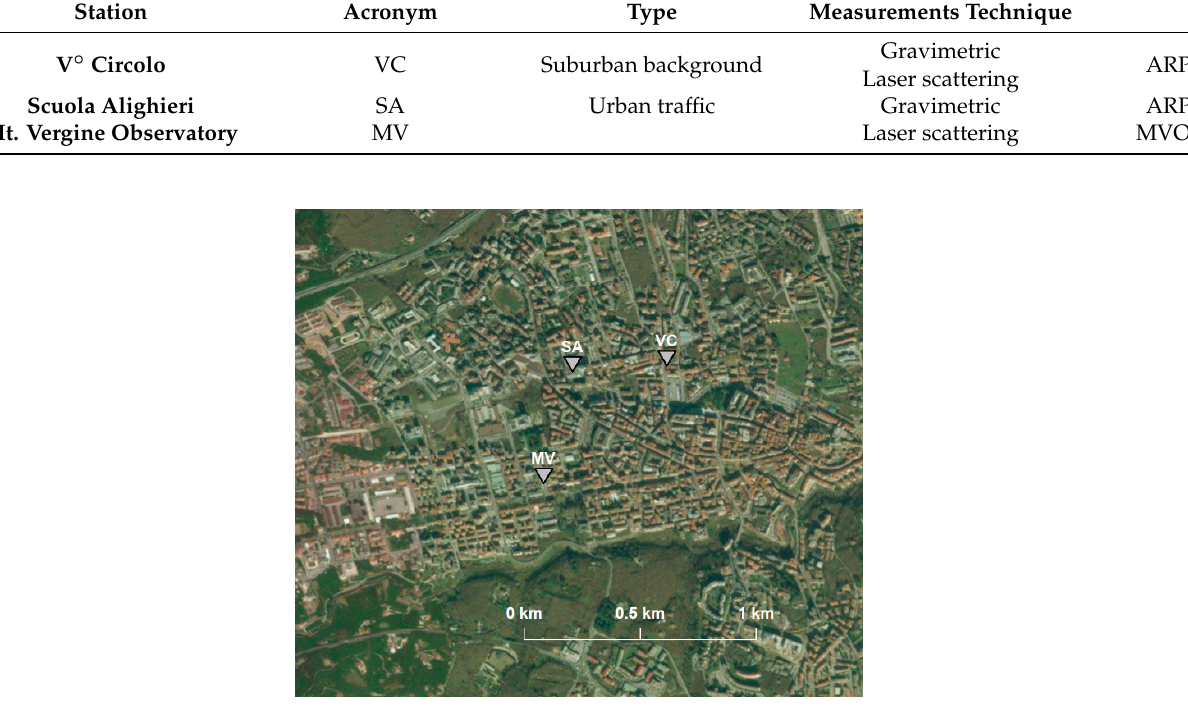
Figure 2. Map of measuring stations located in Avellino. Table 1. Characteristics of the monitoring stations.